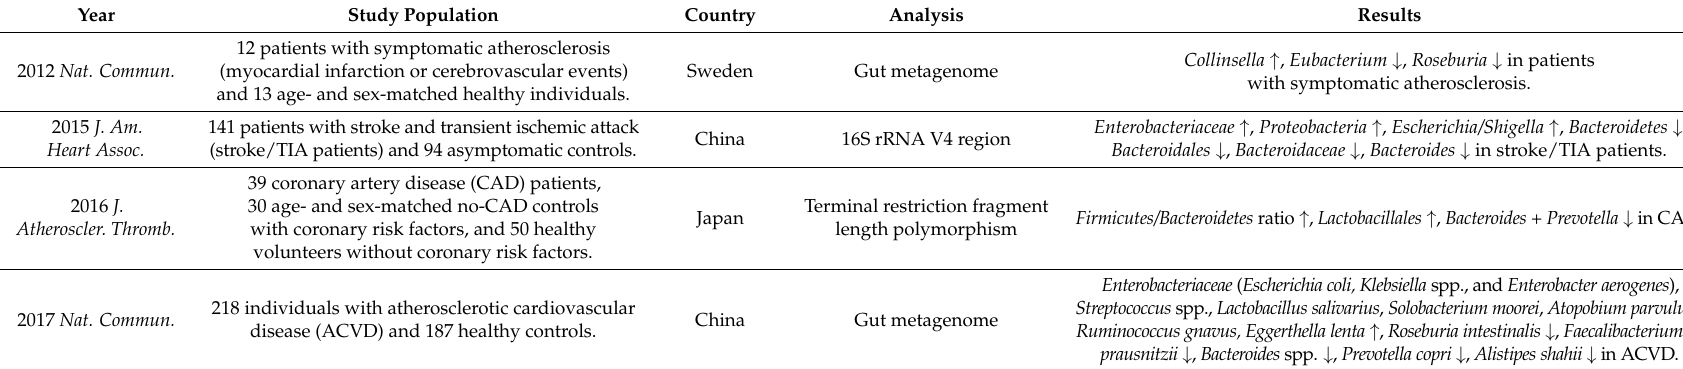
Table 2. Clinical reports demonstrating the gut microbiome in patients with